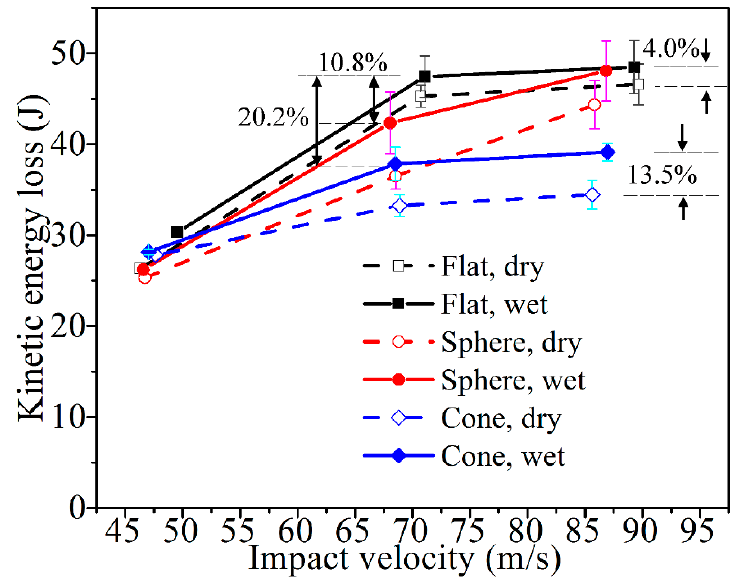
Figure 5. Incident impact energy loss of the CFRP laminates in ‘‘dry’’ and ‘‘wet’’.